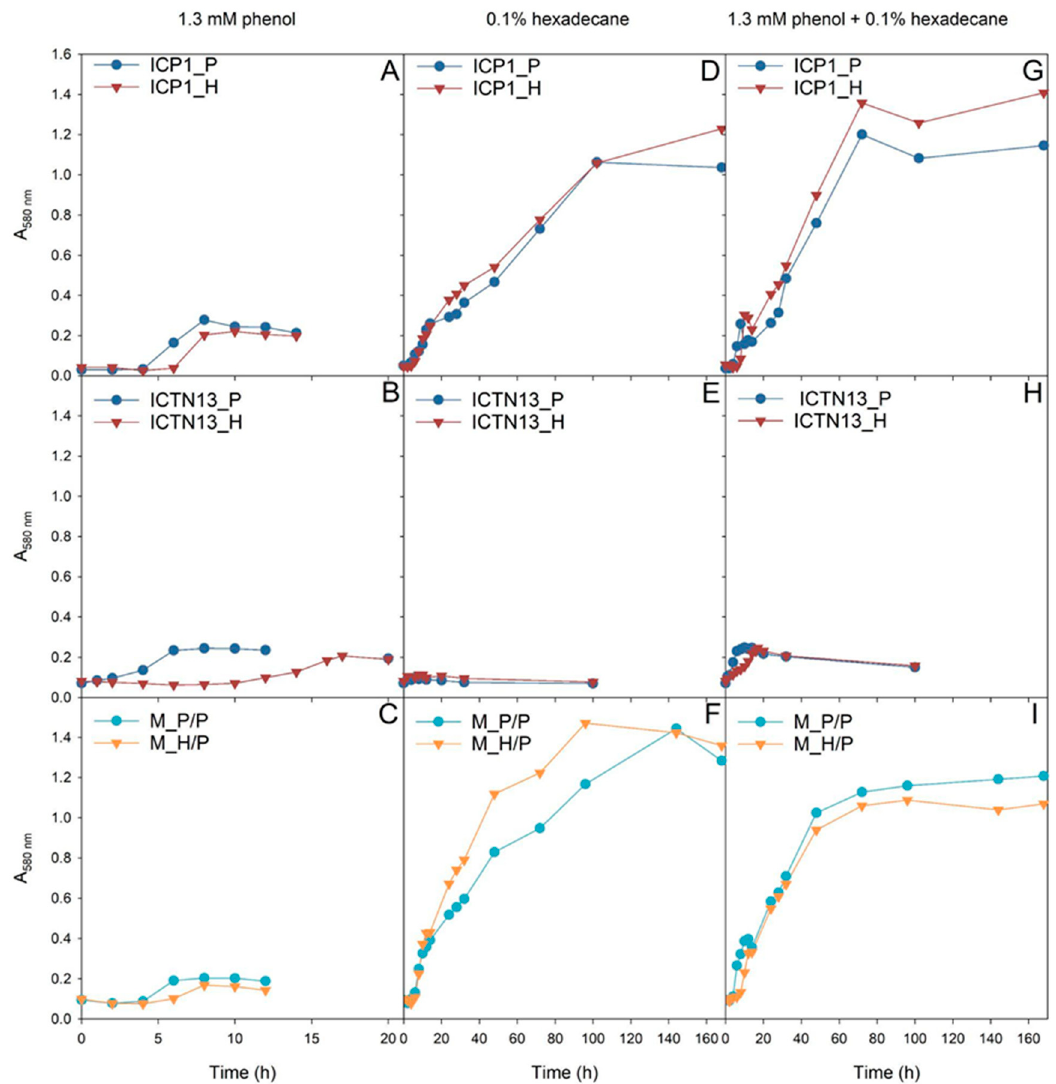
Figure 1. The growth of the A. venetianus strain ICP1 ( A , D , G ), P. oleovorans strain ICTN13 ( B , E , H ), and the mixture of strains ( C , F , I ) on M9 minimal medium containing 1.3 mM phenol ( A – C ), 0.1% hexadecane ( D – F ), or both substrates ( G – I ). The cells of the pure cultures were pre-grown on R2A medium containing phenol (P; blue) or hexadecane (H; red). In the case of the mixture of strains ( C , F , I ), the cells of strain ICTN13 were always pre-grown on phenol-containing R2A medium and strain ICP1 on phenol (P/P; light blue)- or hexadecane (H/P; orange)-containing R2A medium.